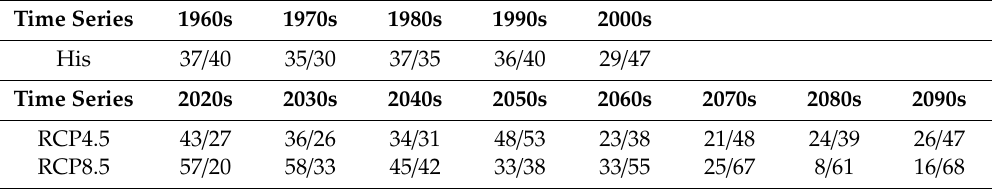
Table 5. Inter-decadal extreme drought frequency historically and in the future. Time Series